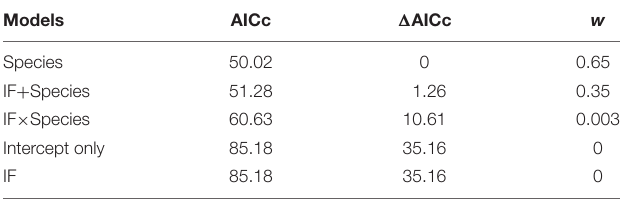
TABLE 2 | Values of the Akaike information criterion adjusted for small sample sizes (AICc), differences in AICc with respect to the best-fitting model ( (cid:49) AICc), and Akaike weights ( w ) for competing models that examined variation in the MI per population.